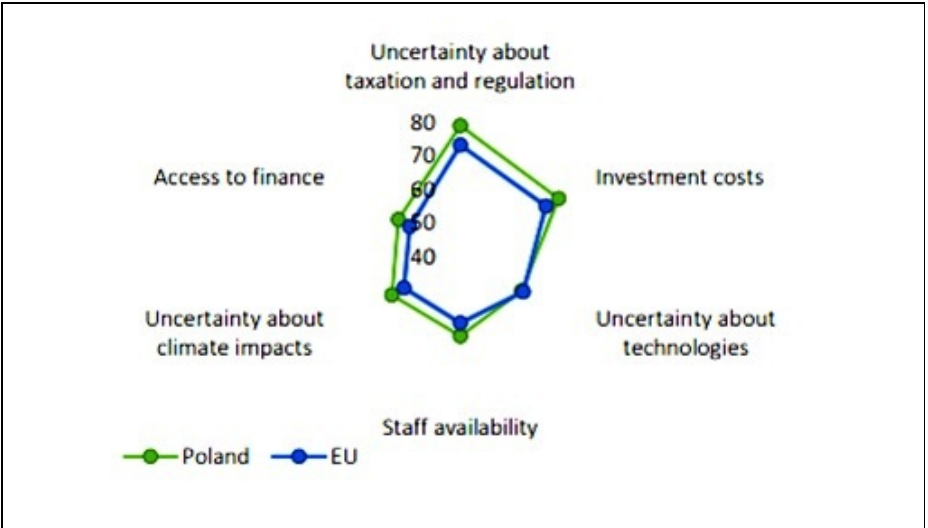
Figure 12. Comparison of companies’ reactions to the climate crisis in Poland and the EU (%).